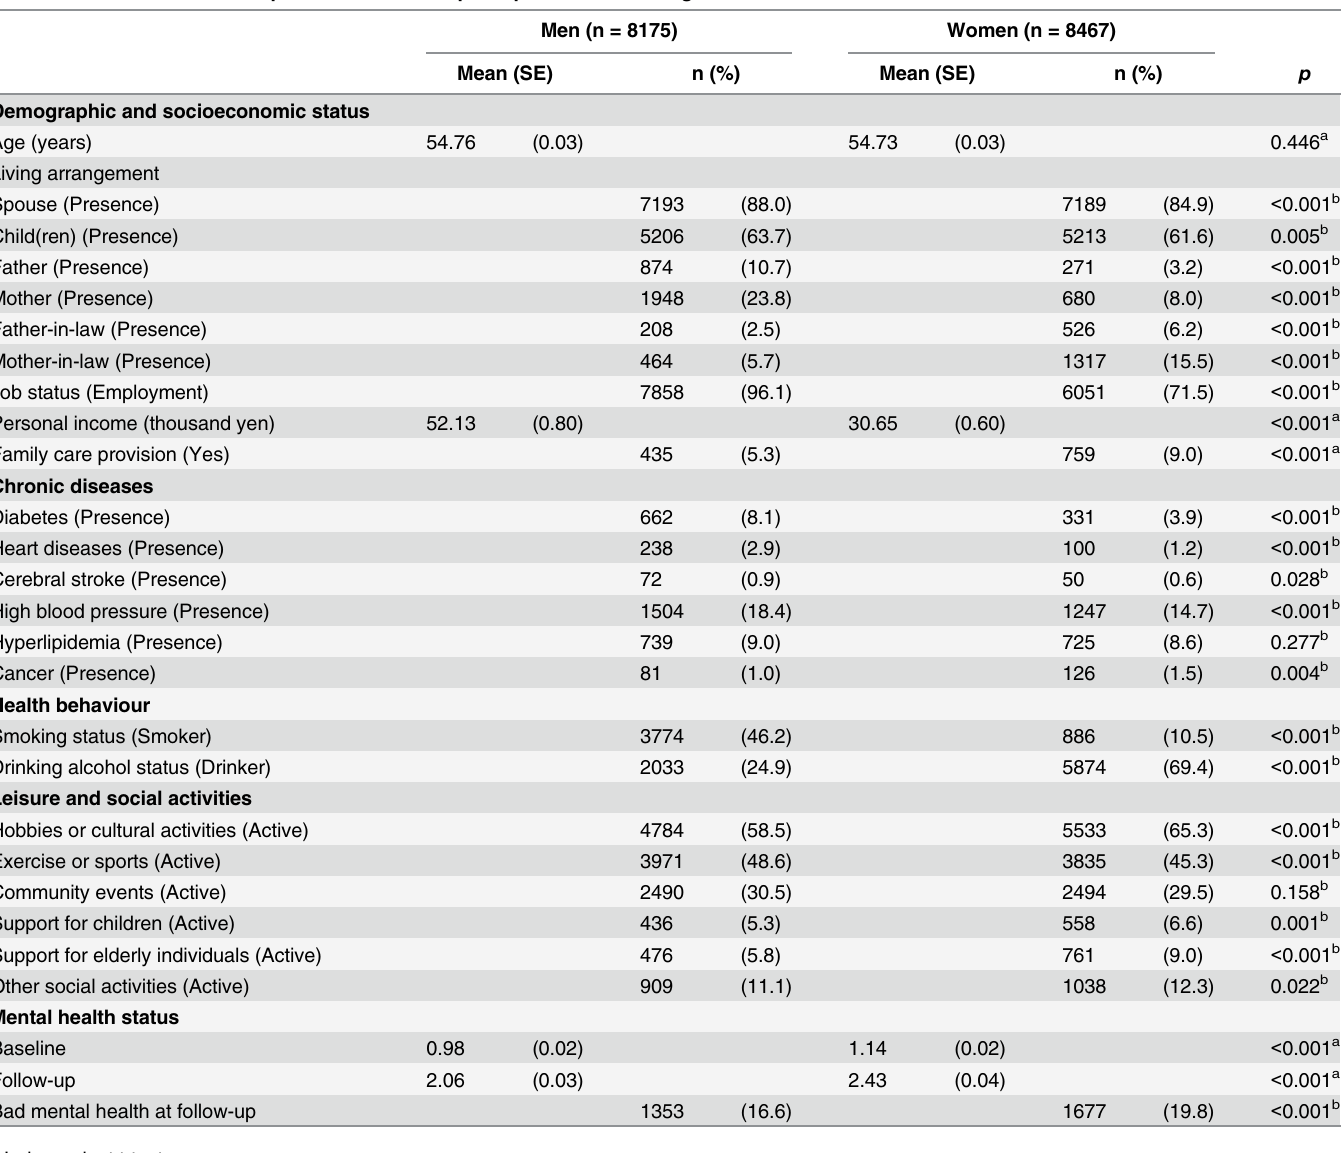
Table 1. Characteristics of respondents after multiple imputation of missing